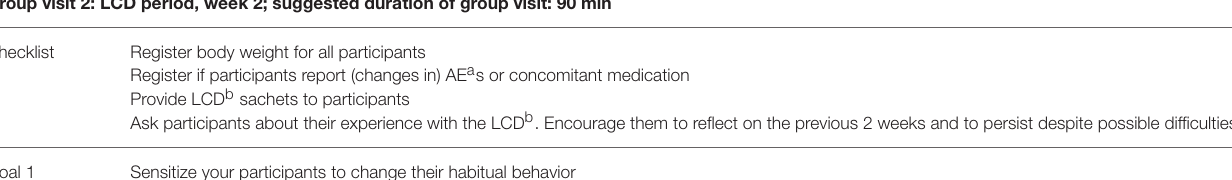
TABLE 2 | Example of a description of a group visit in the PREVIEW study. Group visit 2: LCD period, week 2; suggested duration of group visit: 90